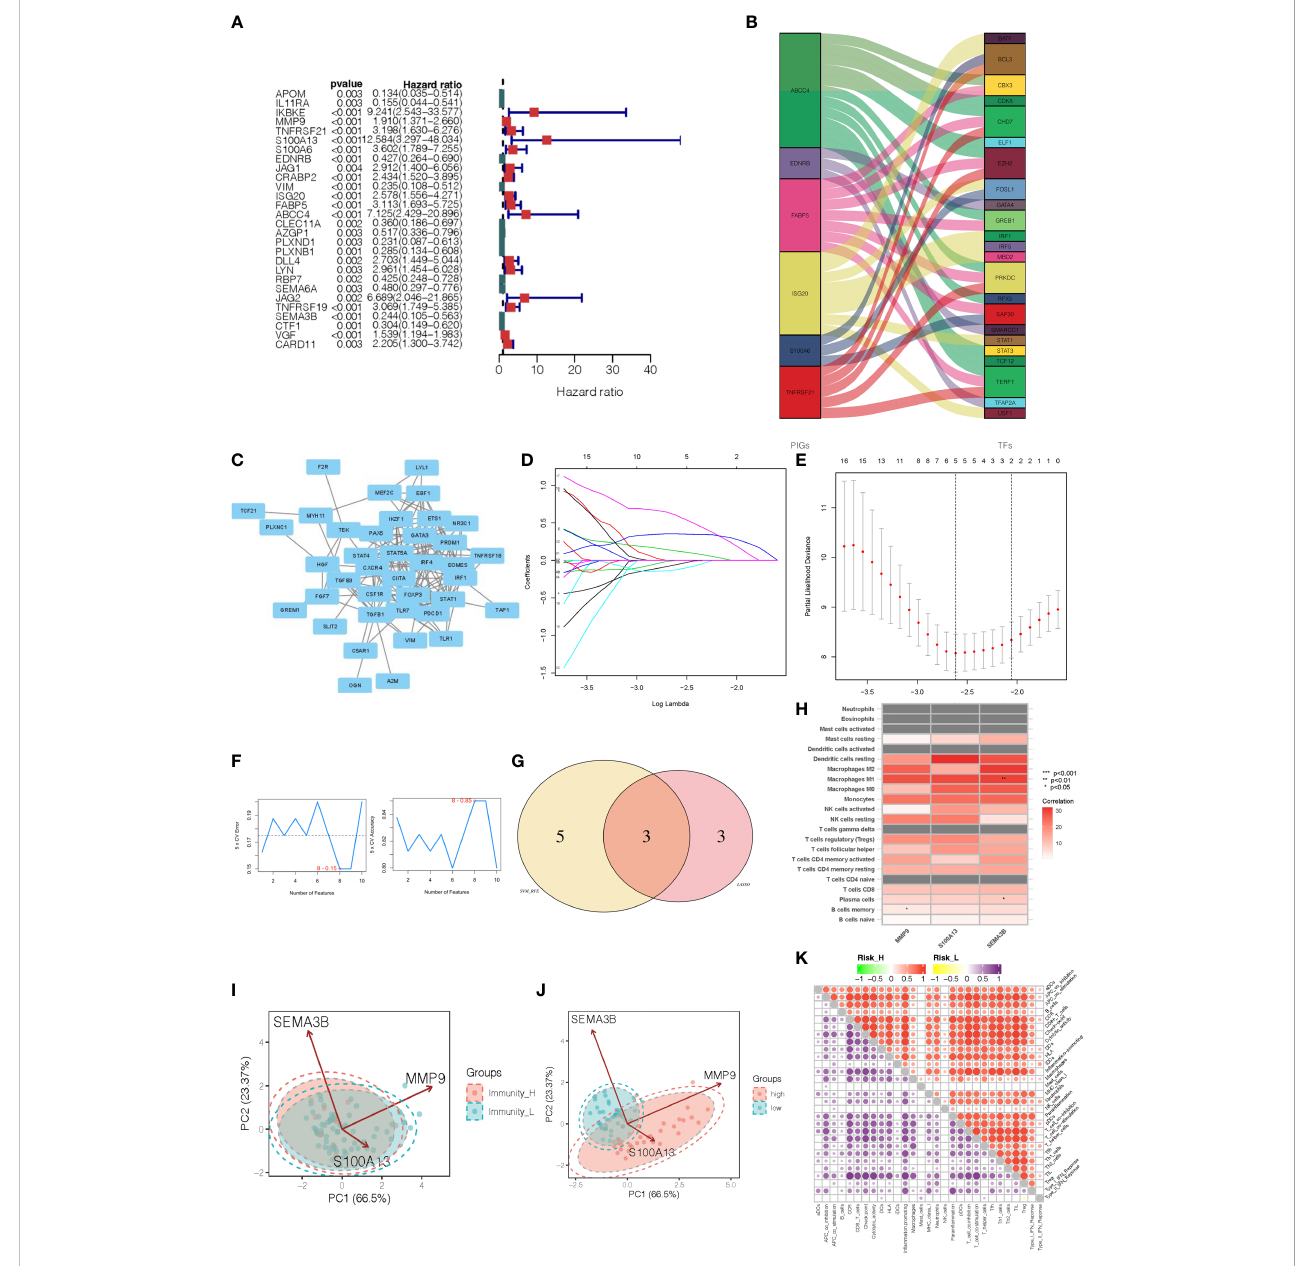
FIGURE 3 Identi fi cation of immune-related gene prognostic signature for uveal melanoma. (A) The HR and p-value from the selected genes in the immune terms using the univariable Cox regression analysis. (B) Alluvial diagram of the relationship between the 28 immune-related genes and transcription factors. (C) The interaction network of those immune-related prognostic genes. (D) The LASSO coef fi cient pro fi les of the 28 immune-related genes. (E) The optimal values of the penalty parameter were determined by 1,000-round cross-validation. (F) The accuracy and error of the estimate yield from SVM-RFE algorithm. (G) The common prognostic features were selected from the overlap of the LASSO and SVM-RFE algorithms. (H) The heatmap showed that the correlation between immune-related prognostic genes and immune in fi ltration cells. (I) PCA analyses for prognostic genes in two immunity level clusters. (J) PCA analyses for prognostic genes in high-risk and low-risk categories. (K) Microenvironmental immune cell pro fi ling of high-risk and low-risk